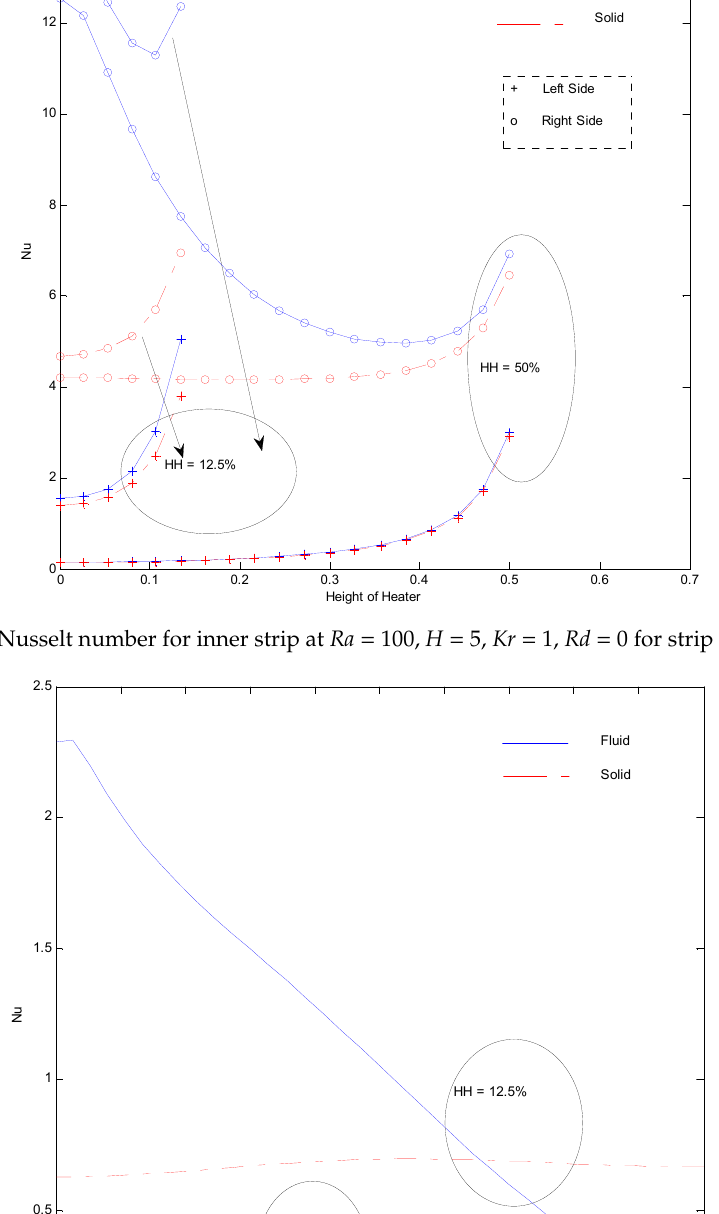
Figure 30. Nusselt number of left vertical surface at Ra = 100 , H = 5 , Kr = 1 , Rd = 0 for strip at 75.0 = x .